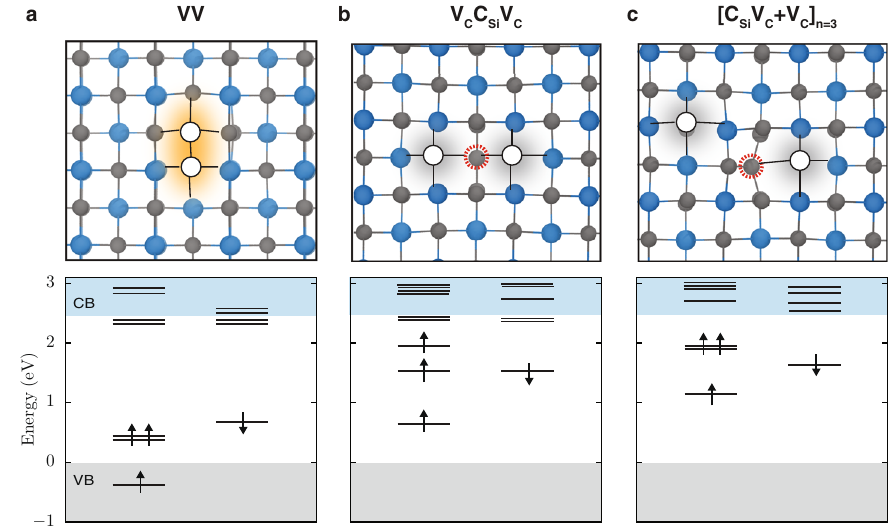
Fig. 6 Electronic structures of VV 0 and antisite-vacancy complexes identi fi ed from MD simulations of VV dissociation. Defect structures (top) and defect energy-level diagrams (bottom) are shown for neutral a , VV, b , V C C Si V C , and c , [C Si V C + V C ] n = 3 . For the [C Si V C + V C ] defect shown here, the two carbon vacancies are separated by at least n = 3 atoms. For each defect, the lowest electronic con fi guration is a triplet state. Shaded gray areas indicate energy levels below the valence band (VB) and above the conduction band (CB). The spin-majority (spin-minority) channel is denoted by upward- (downward-) pointing of silicon to carbon-vacancy concentration is needed. Several of the defect-transformation mechanisms observed in our simula- tions are consistent with and help explain annealing experiments, both in as-grown samples and irradiated/ion-implanted samples. Divacancies are found to undergo crystallographic reorienta- tion without dissociating. These fi ndings indicate that the optimal annealing temperature for reorientation, whose control is of interest for sensing applications, is lower than that required to generate the defects. Beyond having delineated the formation mechanisms of VV, V Si , and C Si V C spin defects, which arise from the dissociation of VV into C Si V C and another V C , we have also discovered plausible new spin defects and characterized their electronic structure using hybrid density-functional theory. Such defects provide new opportunities for quantum technology applications.